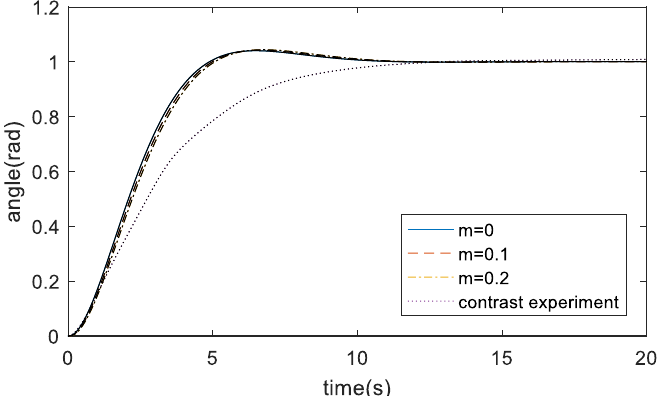
to its optimal value K sd during the learning process. k